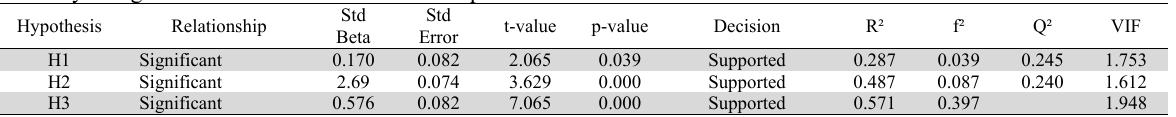
Hypothesis on mediation report analysis result Hypothesis